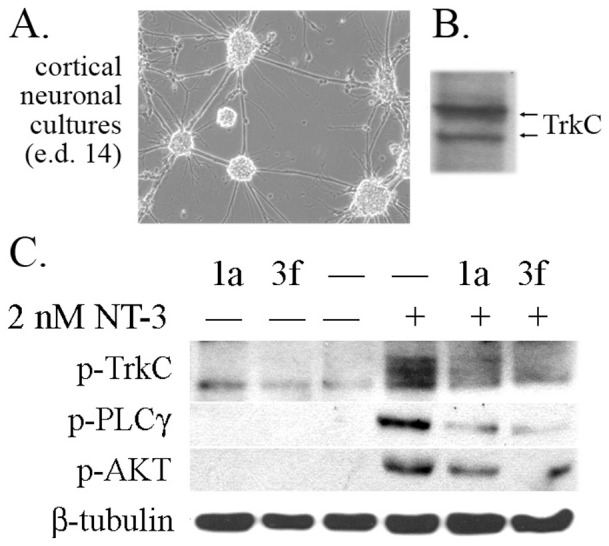
Antagonists of TrkC receptor modulate ligand-dependent signaling pathways in primary neuronal cultures.Primary neuronal cultures were prepared from the cortex of embryonic day 14 mice (ed 14). (A) representative picture of a culture. (B) TrkC is detected in western blots of lysates obtained from these neurons, using anti-TrkC mAb 2B7. (C) Treatment with NT-3 (2 nM for 20 min) induces biochemical signals (p-TrkC, p-PLCγ, p-AKT) that are inhibited by co-treatment with compounds 1a or 3f (10 µM). In the absence of NT-3, the compounds did not have an effect on signals. Control β-tubulin III is loading standard.